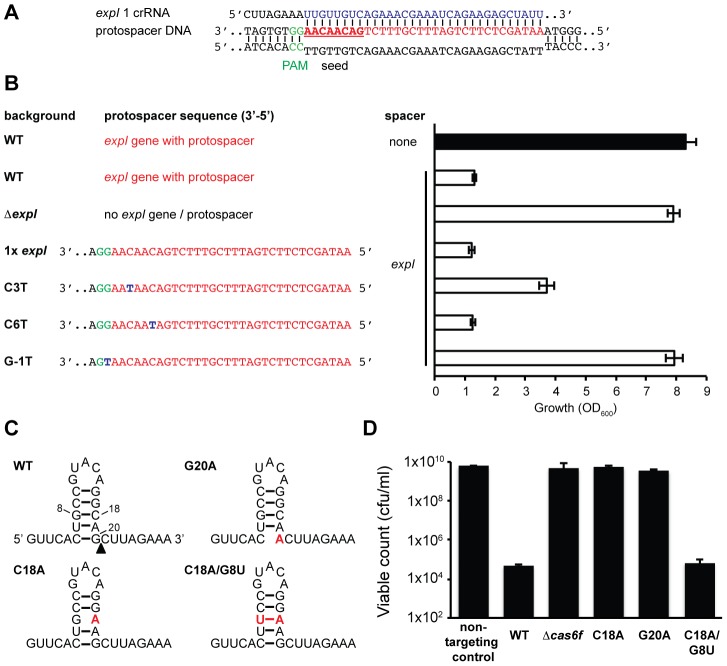
Protospacer, PAM, and repeat mutants can escape toxicity.(A) Predicted pairing between an expI crRNA and the expI protospacer (PAM is green, spacer is blue, protospacer is red and seed sequence is bold and underlined). (B) Left; protospacer sequences in WT, ΔexpI (PCF81), ΔexpI with a single WT (RBV01), C3T (RBV04), C6T (RBV03) or G-1T (PAM) (RBV02) expI protospacer. Right; toxicity assays of a single anti-expI spacer (expI; pE1-16; white bars) or a plasmid with no spacers (none; pC1-16; black bar) when expressed in the backgrounds shown on the left. (C) Predicted folds and position of mutations for WT, G20A, C18A and C18A/G8U single CRISPR repeats. The black triangle represents the site of cleavage by Cas6f. (D) Toxicity assays of plasmids expressing a single anti-expI spacer flanked by either WT (pE1-16), G20A (pE1-16 G20A), C18A (pE1-16 C18A) and C18A/G8U repeats (pE1-16 C18A/G8U) in WT P. atrosepticum.